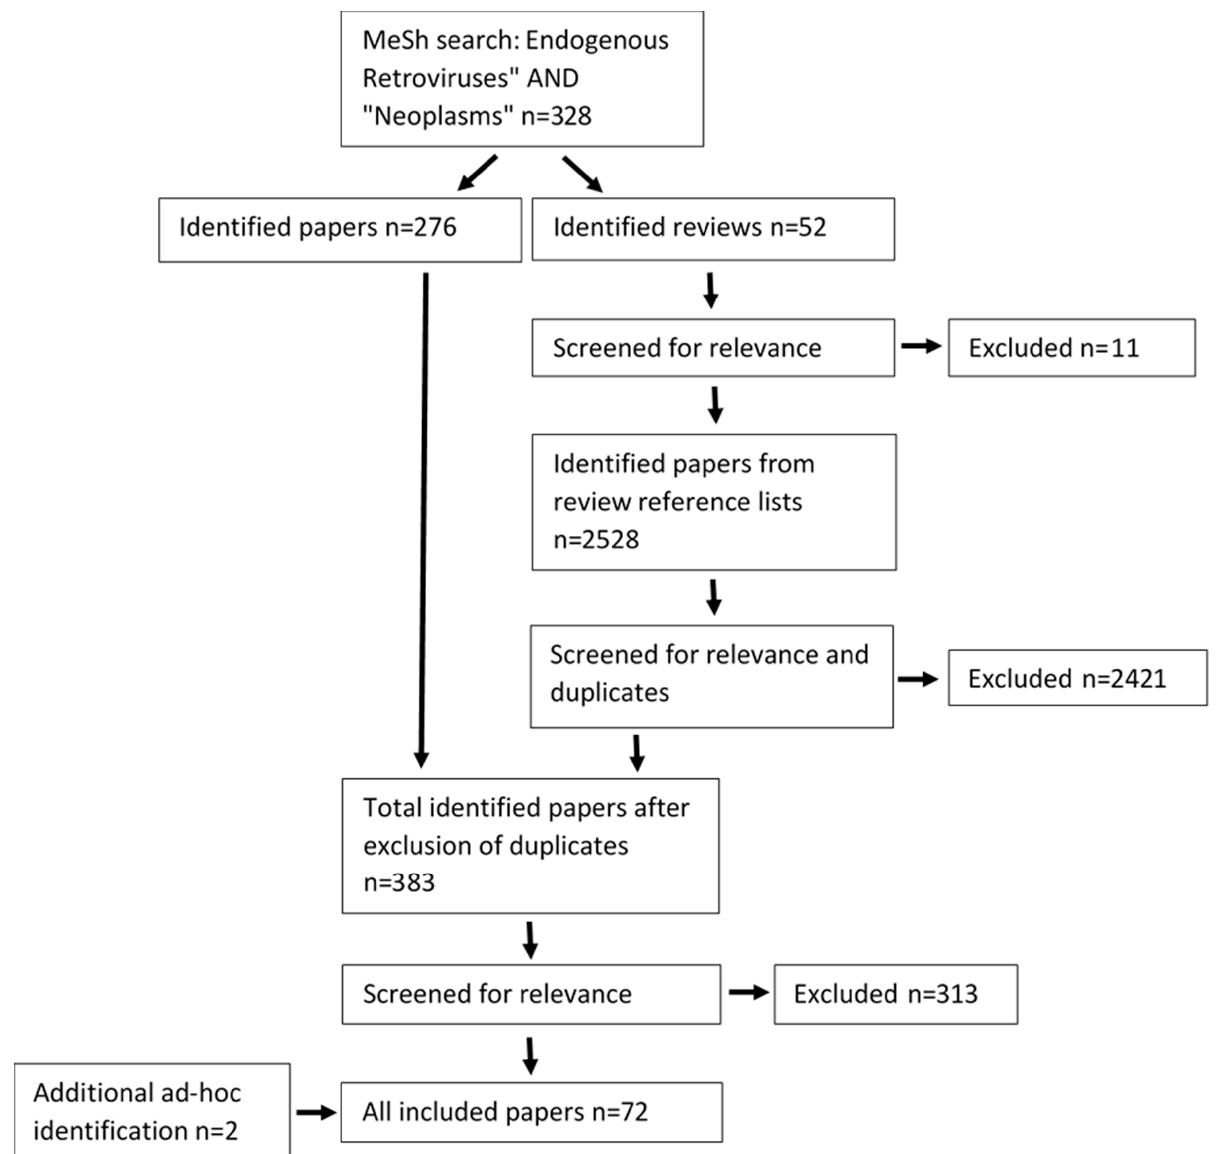
Figure 1. Flowchart on how papers were found and evaluated.